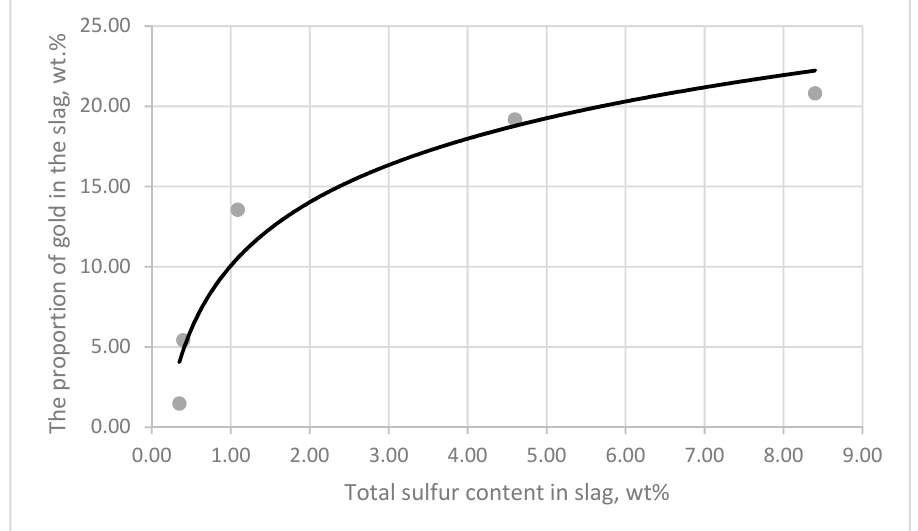
Figure 6. The dependence of the proportion of gold transfer from matte to slag on the total sulfur content in the slag.